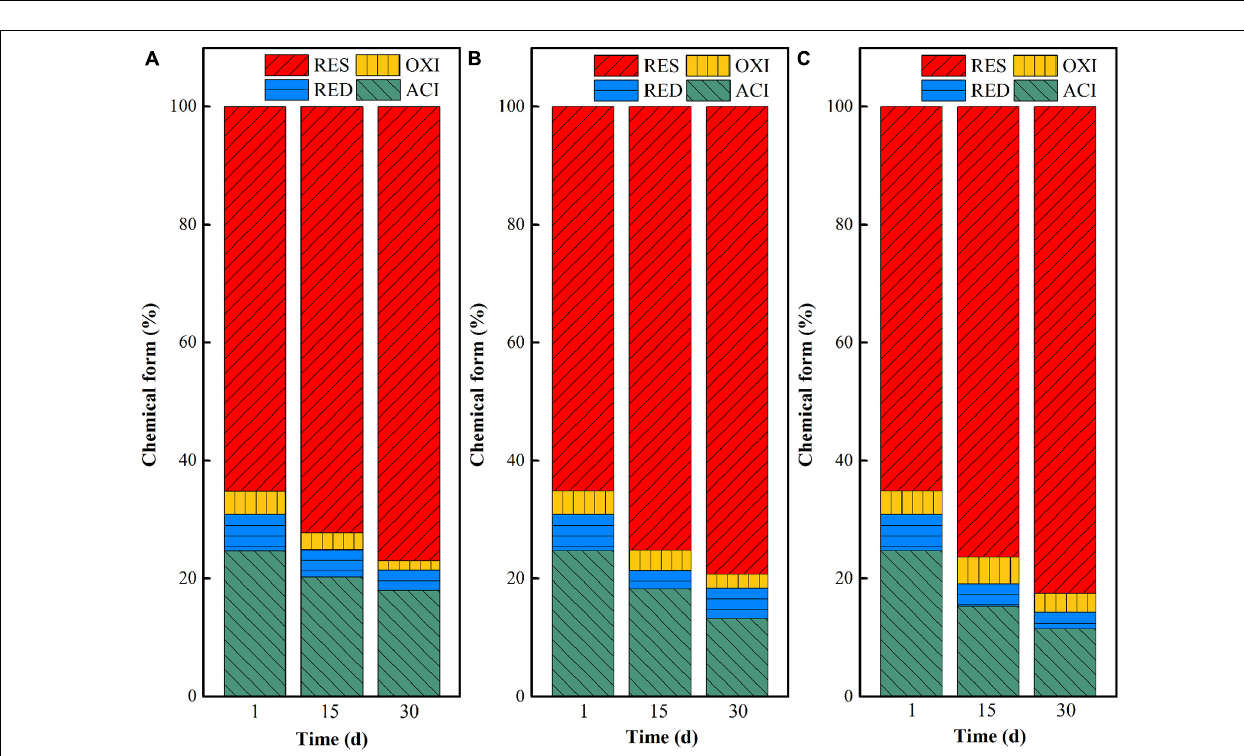
FIGURE 2 | Chemical form (ACI—acid-soluble state; RED—reducible state; OXI—oxidizable state; RES—residual state) changes of uranium in uranium tailings under different pH, (A) pH-3; (B) pH-5; (C) pH-7.